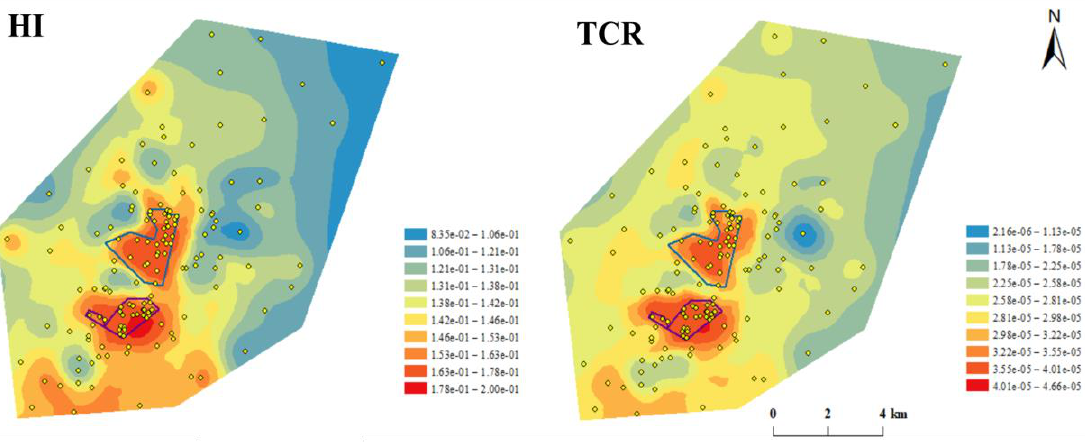
Figure 4. The spatial distribution of HI and TCR for adults.